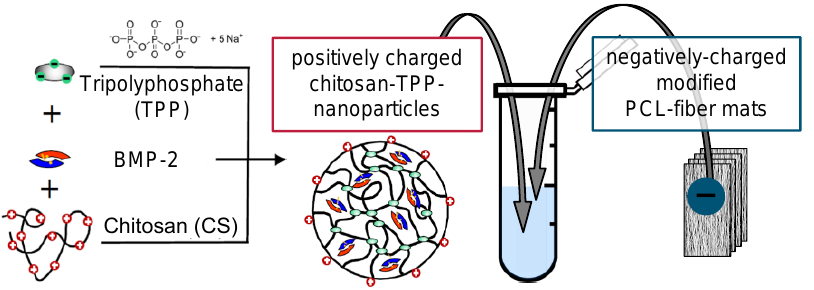
Figure 2. Chitosan coating/BMP-2 loading process of implant prototypes.